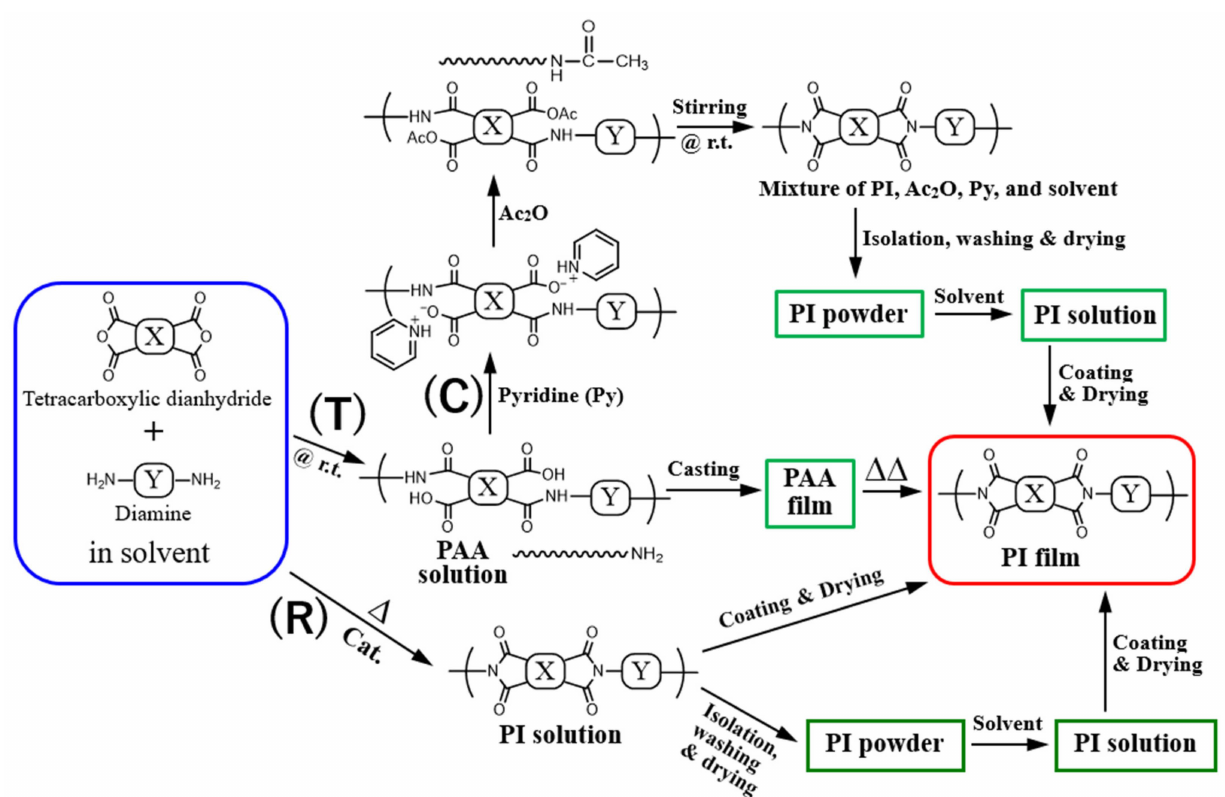
Figure 4. Schemes of polymerization, imidization, and film preparation processes via different routes: ( T ) two-step process, ( C ) chemical imidization process, and ( R ) one-pot polymerization process by refluxing the reaction mixtures in the presence of